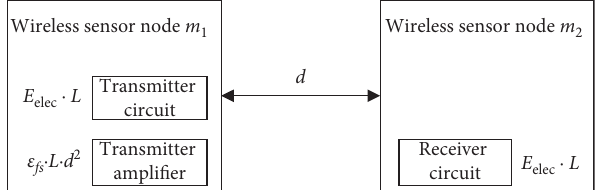
Figure 5: Schematic diagram of energy consumption for SN data